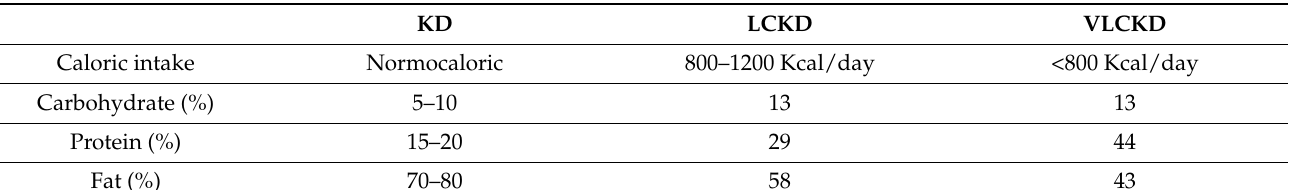
Table 1. Characteristics of classical ketogenic diet (KD), low-calorie ketogenic diet (LCKD) and very low-calorie ketogenic diet